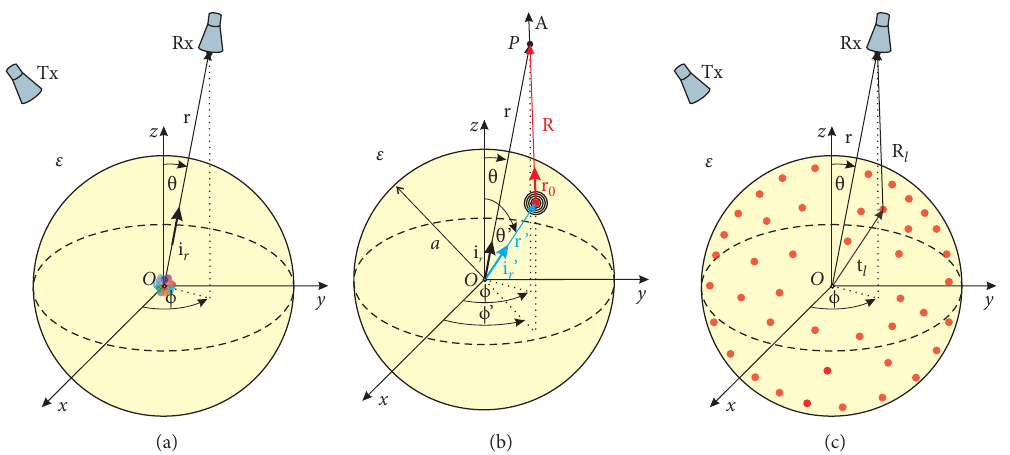
Figure 1: (a) Multipoles of various orders, depicted as small spheres collocated in the scatterer’s center. (b) Computation of the radiation pattern of a multipole of the order ( m , n ). (c) Spatial array of multipoles of the order ( m , n